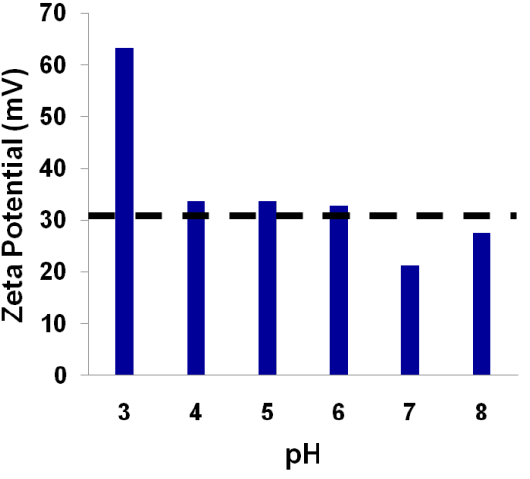
synthesized in methanol at various 3